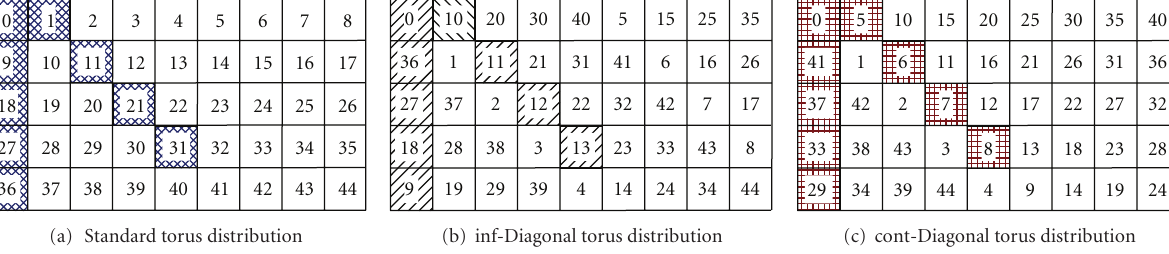
Figure 7: Standard (a), inf-Diagonal (b), and cont-Diagonal (c) torus